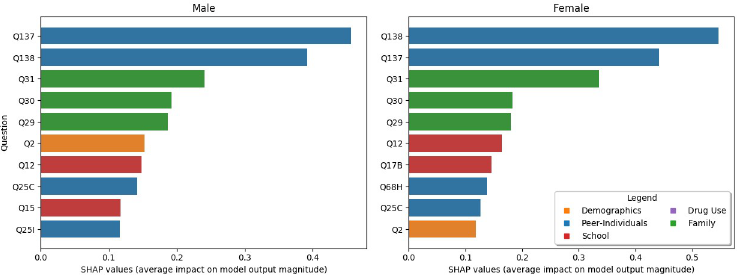
Fig 7. The top 10 most important questions for males vs females. Note that compared to Fig 3 the majority of the questions are the same, however, there are a few slight differences described in the the main text, such as age (Q2), physical aggression (Q25I) and hating school